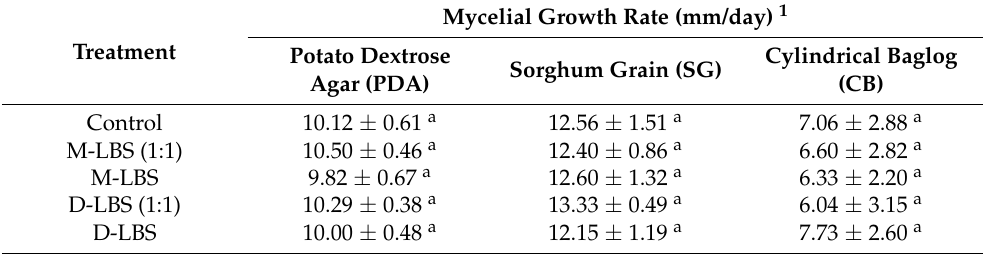
Table 1. Mycelial growth rate on different solid cultural media at room temperature (30 ◦ C ± 2 ◦ C) for Potato dextrose agar (PDA) and Sorghum grain (SG) and at 24 ◦ C–30 ◦ C for cylindrical baglog